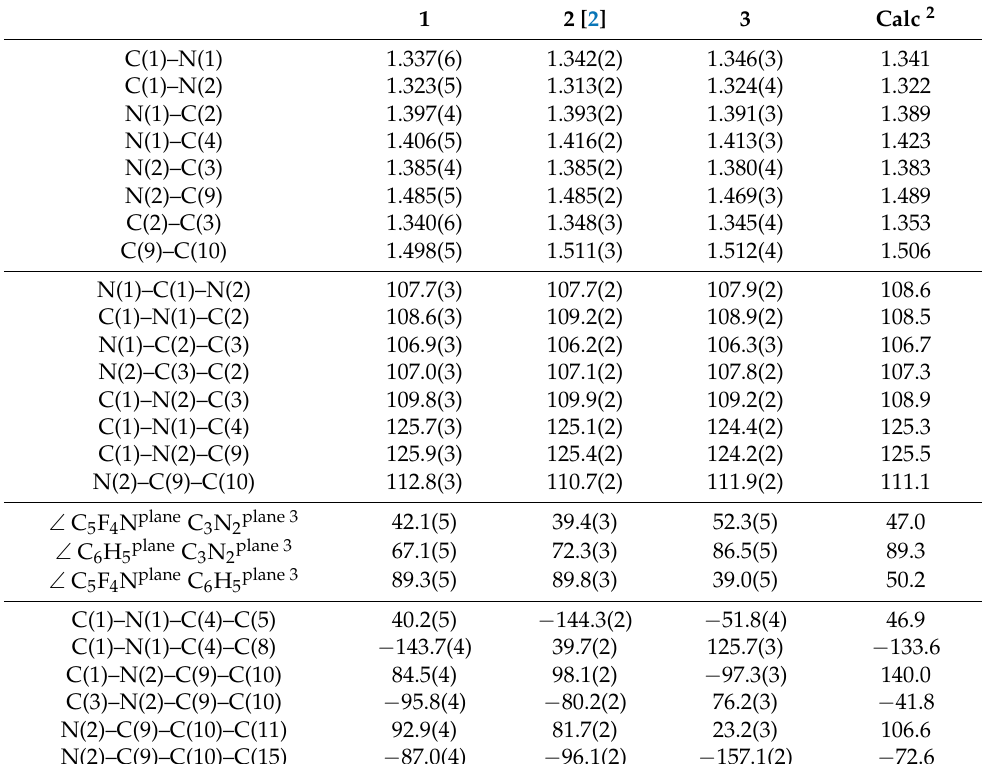
Table 2. Selected experimental and calculated bond distances (Å) and angles ( ◦ ) for